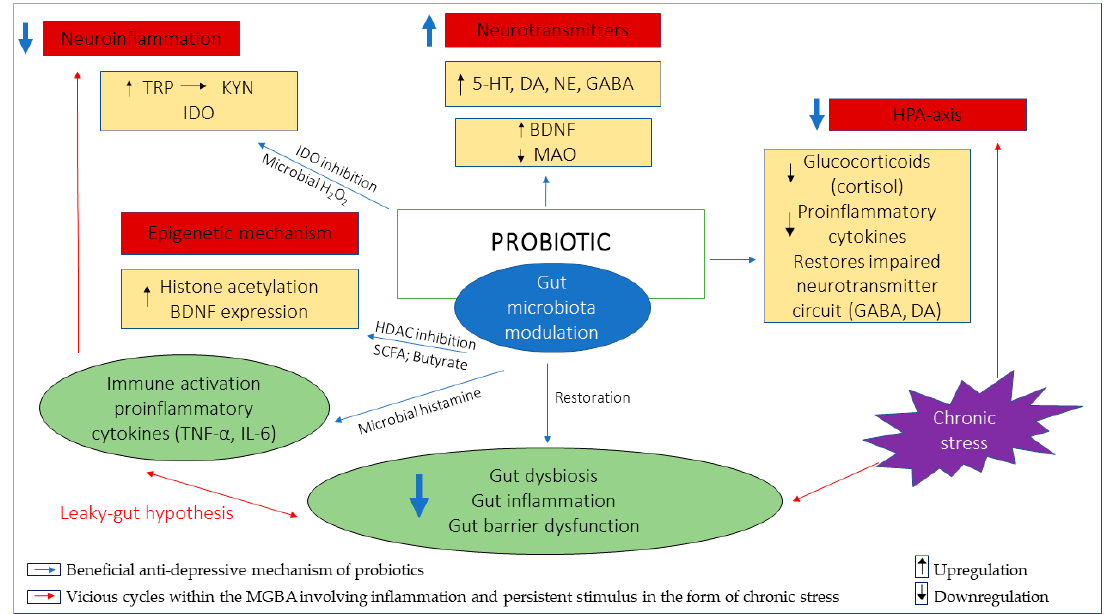
Figure 1. Illustration of potential anti-depressive mechanisms of probiotics, fundamentally involving gut microbiota modulation. The restoration of gut dysbiosis, inflammation and gut barrier dysfunction downregulates inflammation involving the TRP/KYN pathway which is implicated in depression and breaks the vicious cycles involving inflammation, the HPA-axis and persistent stimulus in the form of chronic stress. Probiotics promote synthesis of neurotransmitters either directly or indirectly by increasing BDNF levels and/or decreasing MAO levels to mediate anti-depressive effects. Probiotics attenuate exaggerated HPA-axis implicated in depression through downregulation of cortisol, proinflammatory cytokines and restoration of neurotransmitter circuits involving GABA and DA neurotransmitters. The epigenetic mechanism mainly involves butyrate-producing probiotics which inhibit HDAC and promote histone acetylation while upregulating BDNF expression. Tryptophan (TRP); Kynurenine (KYN); Indoleamine 2,3-dioxygenase (IDO); Serotonin (5-HT); Dopamine (DA); Noradrenaline (NE); Gamma-Aminobutyric acid (GABA); Brain-derived neurotrophic factor (BDNF); monoamine oxidase (MAO); Hydrogen peroxide (H2O2); Short-chain fatty acid (SCFA); Histone deacetylase (HDAC); Interleukin-6 (IL-6); Tumor necrosis factor- α (TNF- α ).